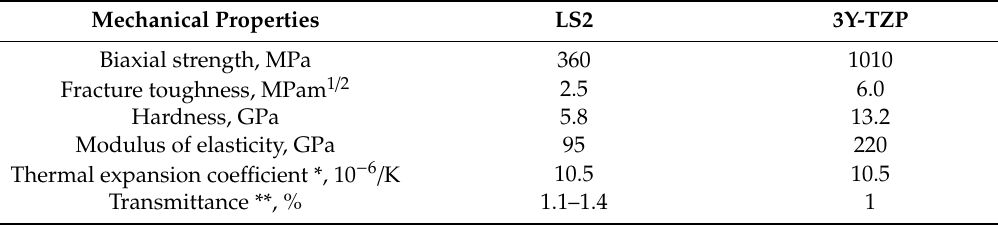
Table 2. Comparison of the mechanical properties of lithium disilicate glass (LS2) and 3Y-TZP. Mechanical Properties LS2 3Y-TZP Biaxial strength, MPa 360 1010 Fracture toughness, MPam 1 / 2 2.5 6.0 Hardness, GPa 5.8 13.2 Modulus of elasticity, GPa 95 220 10.5